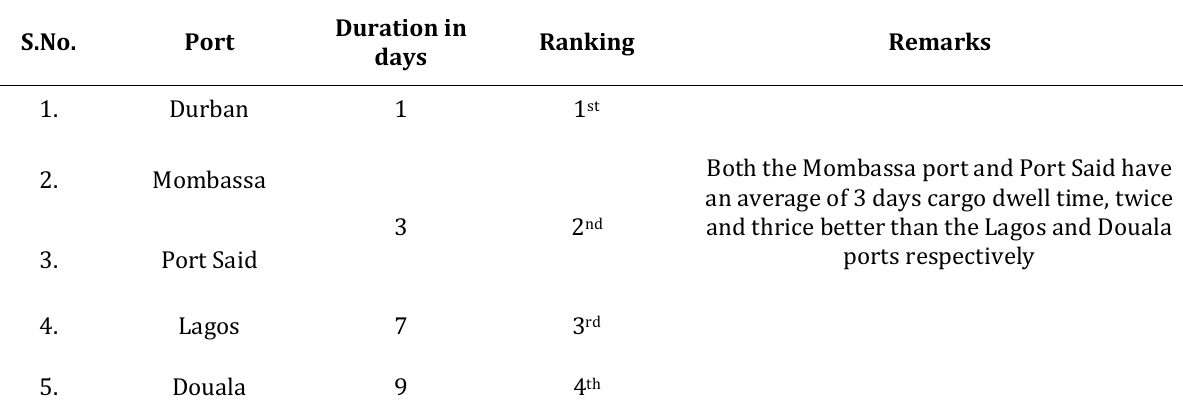
Table 4.4: Storage Dwell Time in Port S.No.